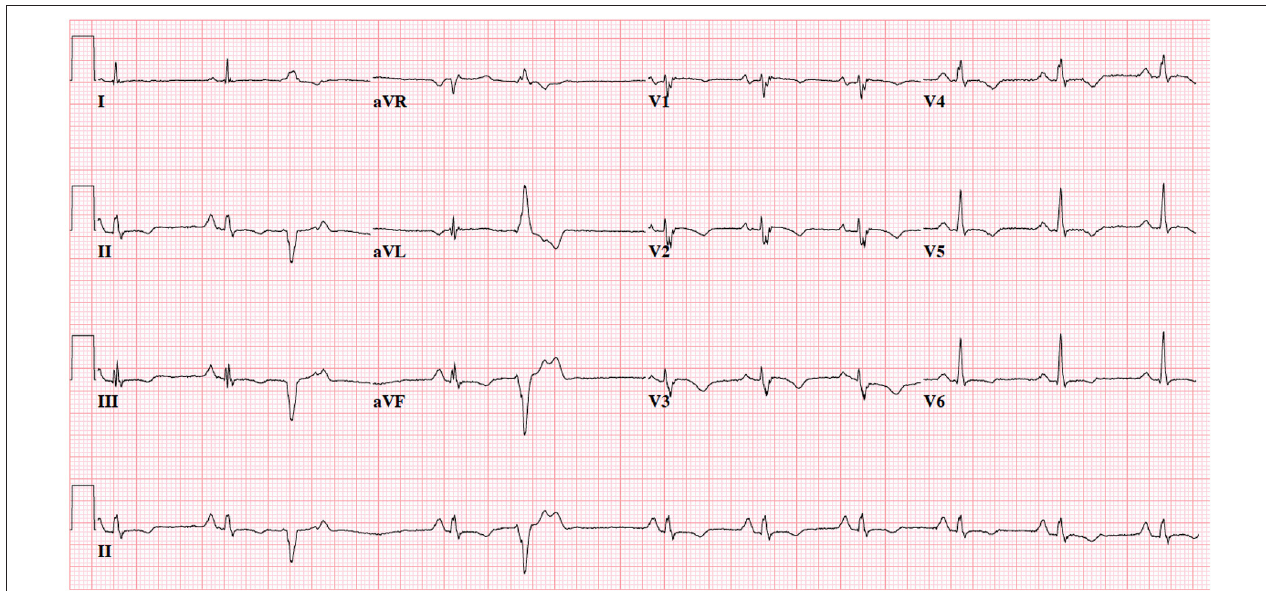
FIGURE 2 | 12-Lead electrocardiogram of 19-year old female with advanced ARVC. Note normal sinus rhythm with frequent premature ventricular complexes with superior axis morphology, voltage criteria for right atrial enlargement, borderline prolonged QRS duration (QRS 0.10s) with fractionated upstroke in V1-3 (“terminal activation duration” > 55ms), and negative T-waves in V1-6 and inferior leads. This patient would fulfill 1 major (T-wave inversion V1–V3 and beyond) and 1 minor criterion (prolonged terminal activation duration) for ARVC. ECG settings: 25 mm/mV; 10 mm/mV; 150Hz.